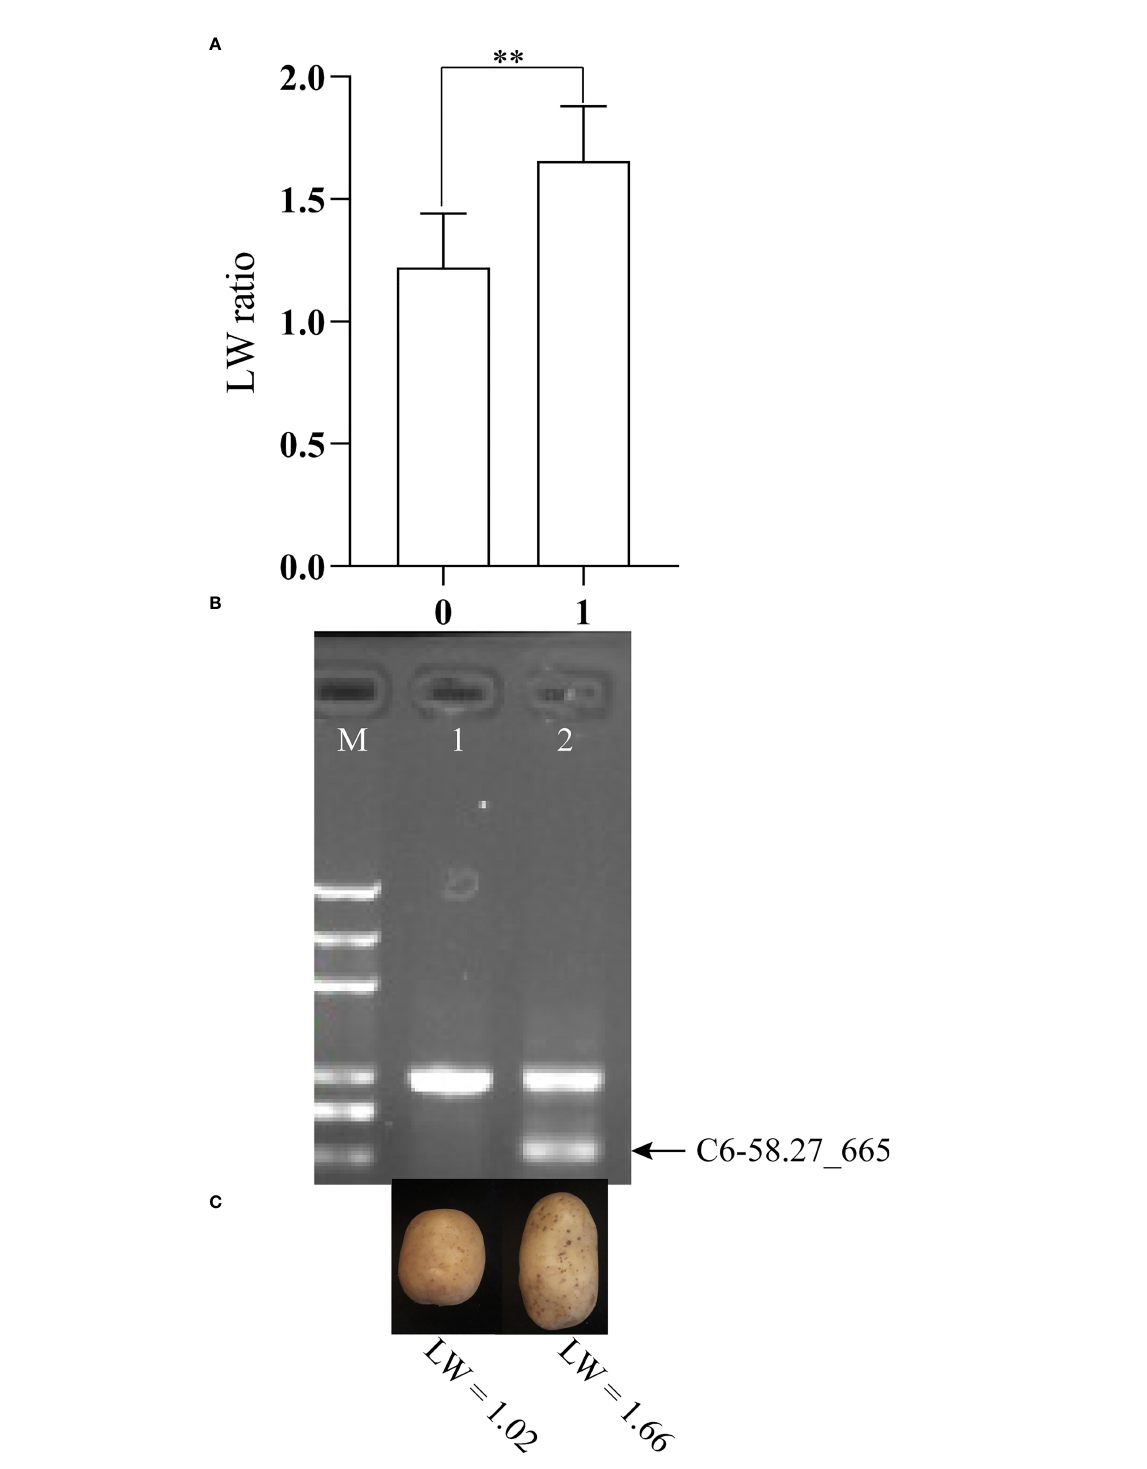
FIGURE 5 The effect of the tuber shape QTL was analyzed further by the occurrence of the QTL peak marker C6-58.27_665 in a natural population. (A) The difference analysis of LW value between 0 and 1. 0, the individuals lacked the marker C6-58.27_665; 1, the individuals carried the marker C6-58.27_665. **p < 0.01 in Student t test. (B) Detection of the CAPS marker C6-58.27_665 in natural polation. The PCR products were electrophoresed on 0.8% agarose gel. Lane M, 2 kb plus DNA ladder (Trans, China), and sizes of the ladders are 5000, 3000, 2000, 1000, 750, 500 bp, respectively. (C) The tuber shape of potato lines with (right) and without (left)